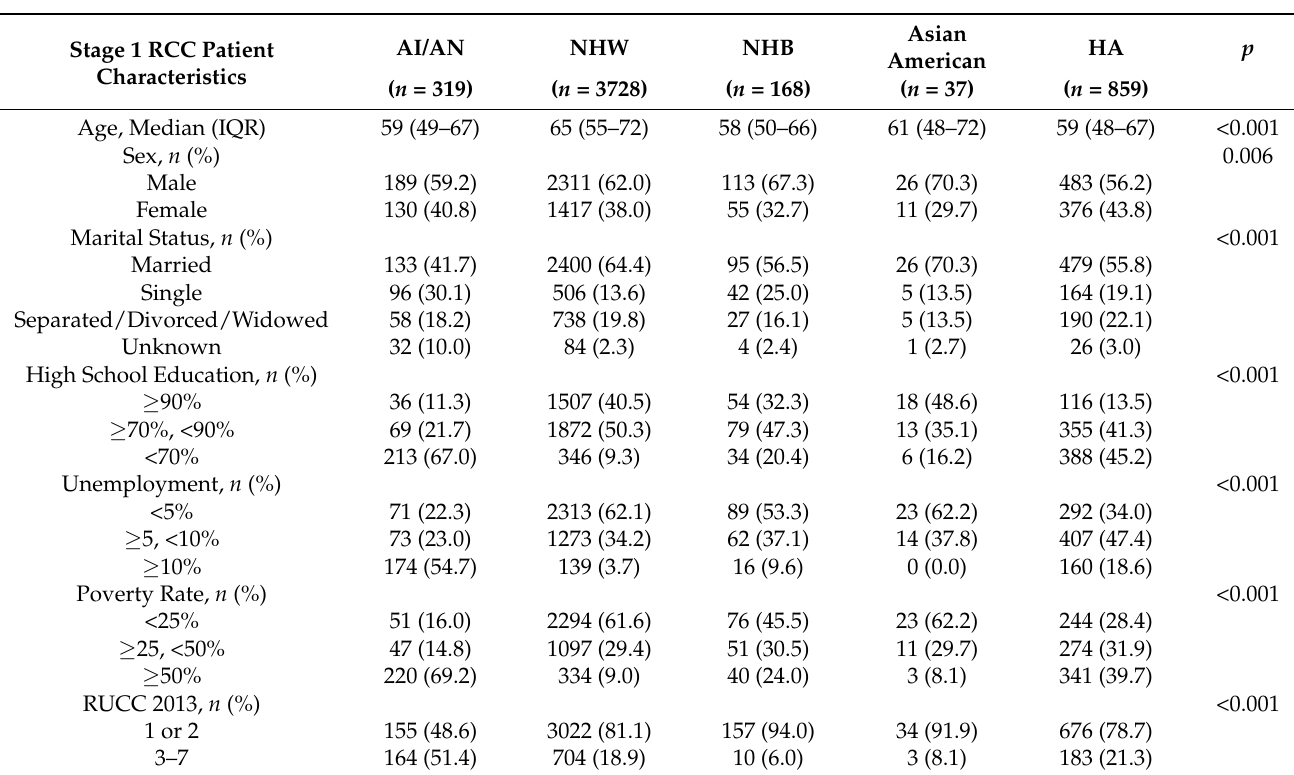
Table 1. Stage I RCC patient characteristics across racial/ethnic groups in the Arizona Cancer